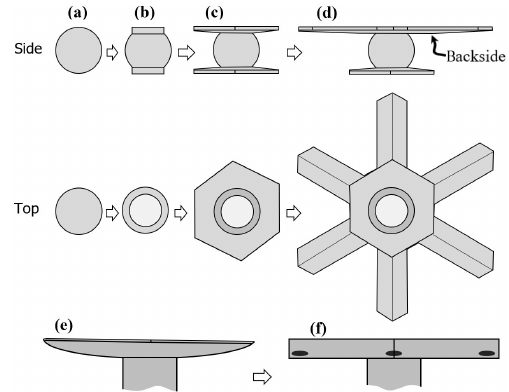
Figure B4. Facet spreading and protruding growth on a droplet or column under constant or varying conditions. Panels (a) – (d) follow the description first given by Akira Yamashita (personal communi- cation, 2014). Here, the growth on a frozen droplet leads to pro- truding growth and a two-level snow crystal. For sketches in (d) , compare the side view to images in Fig. B3 and the top view to the snow crystal in Fig. 8c. (e) Cap on one end of frozen droplet or col- umn, showing rounded backside. (f) Same cap after a decrease in growth rate, allowing corner pockets to form. Details of the process between (e) and (f) are not shown but would be the same as that shown in Fig. 4 except that only one side of the crystal is rounded. This latter process may explain the observed line of pockets on the inset image in Fig.